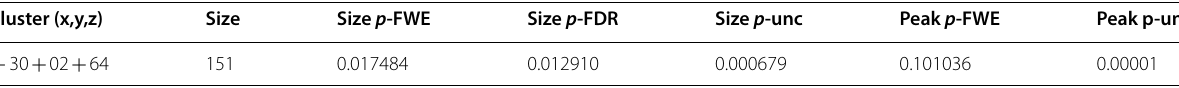
Table 2 Seed‑to‑voxel functional connectivity for the salience network (SN) as seed region